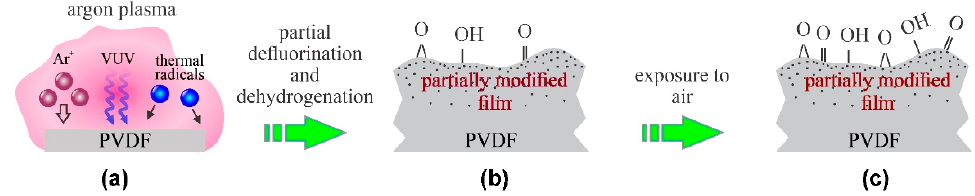
Figure 2. Mechanisms involved in surface modification of PVDF upon exposure to diffusing argon plasma with samples kept at the floating potential: ( a ) polymer is exposed to slow ions, weak VUV radiation and radicals or residual atmosphere, ( b ) formation of a gradient surface film and radical- dependent surface oxidation, and ( c ) full surface oxidation upon exposure to ambient conditions.